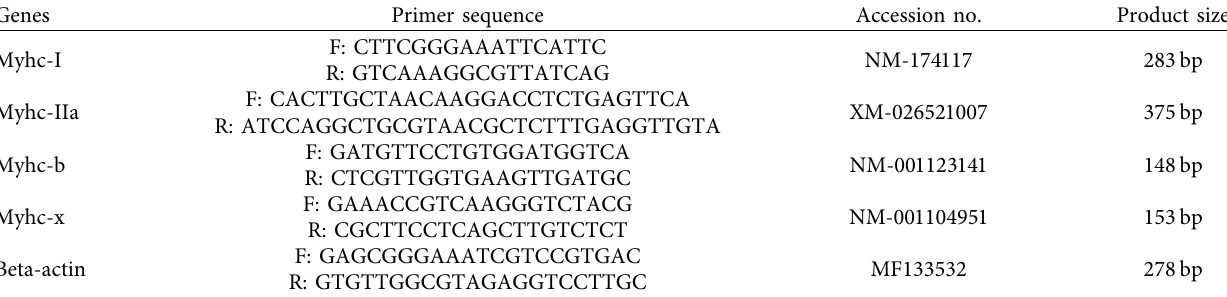
Table 1: Primer sequences used in quantitative polymerase chain reaction.